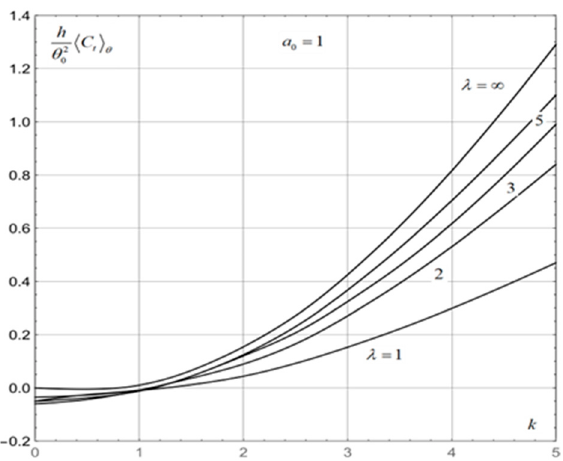
Figure 14. Period-averaged thrust coefficient of a rectangular wing pitching in extreme ground effect versus Strouhal number for different aspect ratios and a 0 = 1.